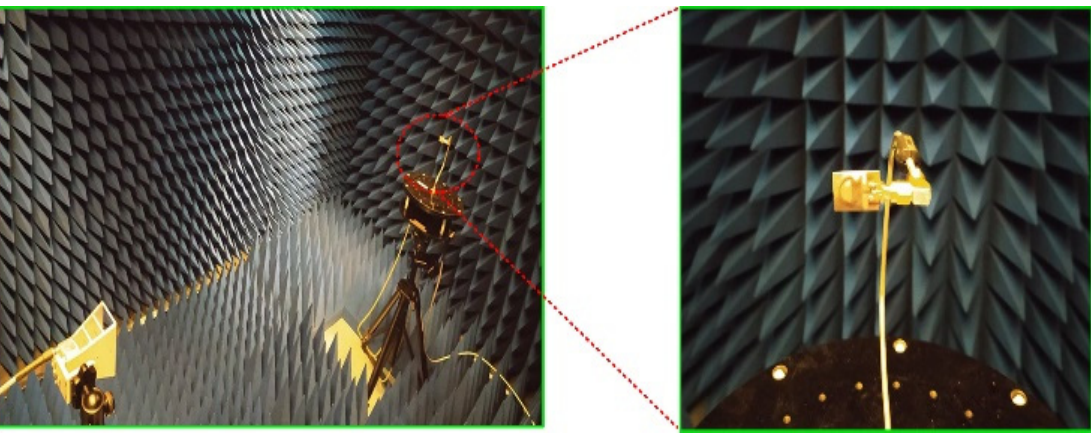
Figure 10. Measurement setup for far-field analysis of the propped flexible UWB antenna.